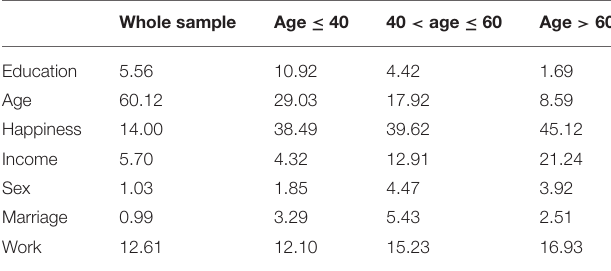
TABLE 7 | Decomposition of contribution rate